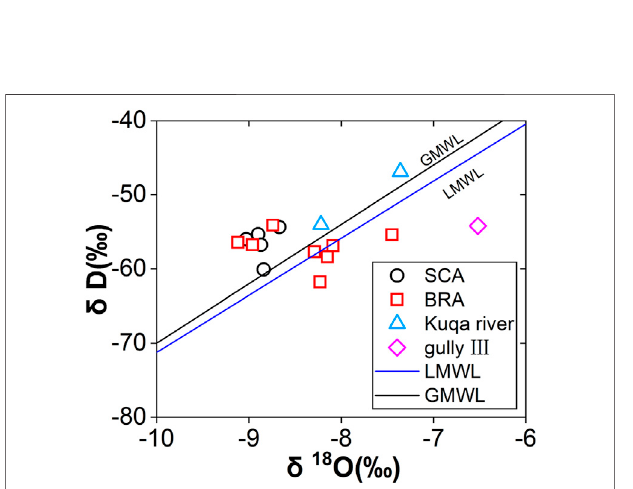
FIGURE 11 | Annual average mine water in fl ow from 2011 to 2020 in coal